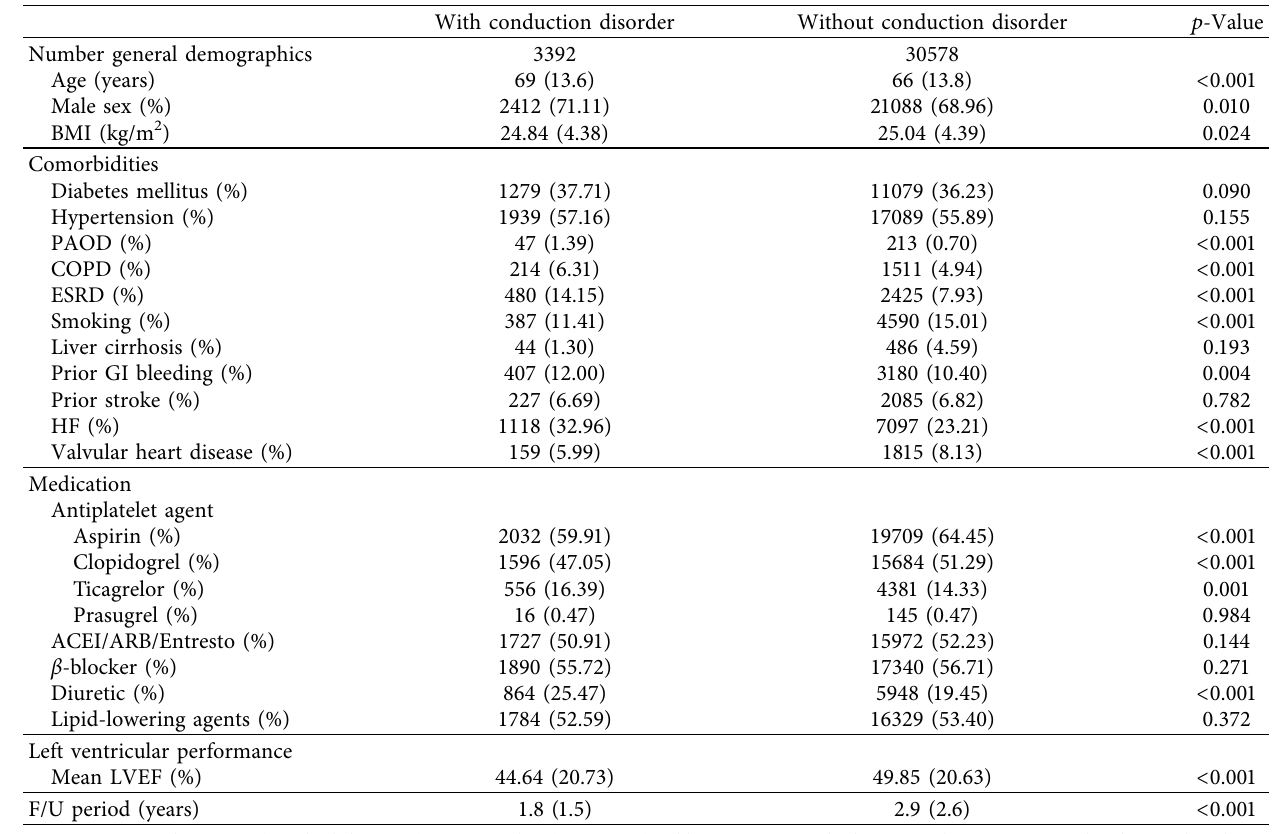
Table 1: Baseline characteristics and clinical outcomes in the patients with and without conduction